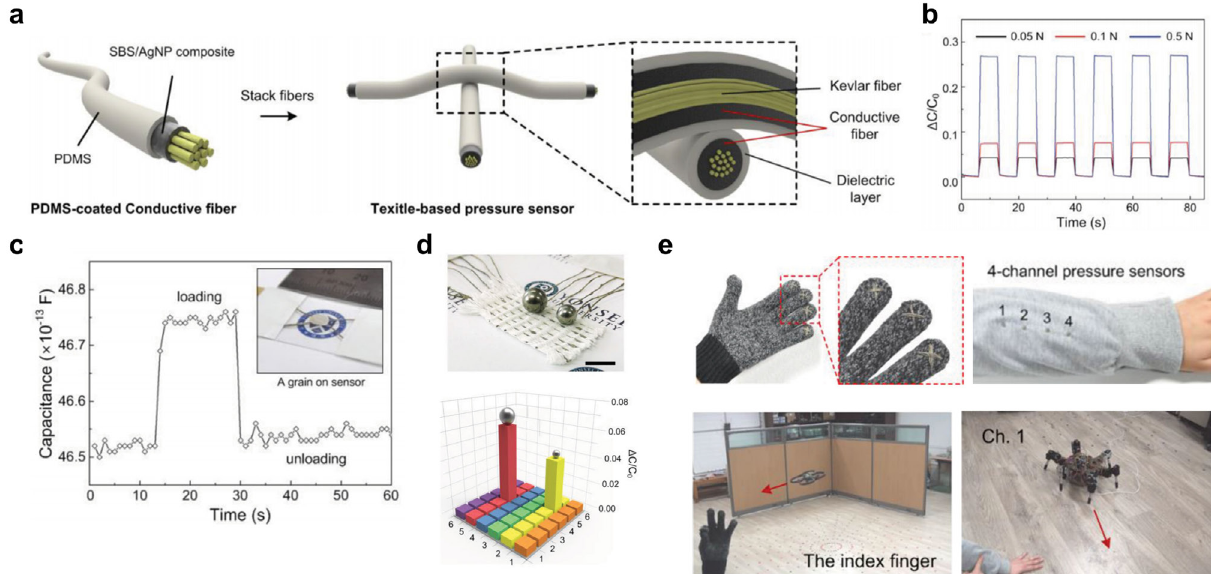
Figure 7. ( a ) Schematic structure of a textile-based pressure sensor fabricated with PDMS-coated conductive fibers; ( b ) Capacitive response of the pressure sensor for the various applied loads; ( c ) Capacitive response of the pressure sensor to the placing and removal of a grain (8 mg); ( d ) Fabrication of pixelated pressure sensor array; ( e ) Photographs of the smart glove and clothes with textile-based pressure sensors and operation using smart glove and clothes to control the drone and spider robot. Reprinted from [20] with permissions by John Wiley & Sons, Copyright